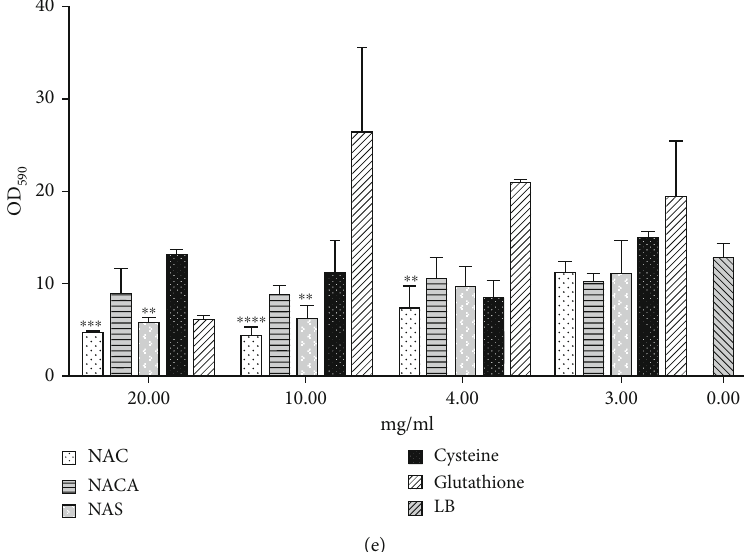
Figure 9: The e ff ects of NAC and similar molecules in dismantling bio fi lm. (a) Structures of molecules similar to NAC used in this experiment: N -acetyl-cysteine amide (NACA), N -acetyl-serine (NAS), cysteine (Cys), and glutathione (GTH). (b) Chronic wound microbiome bio fi lm formation after the treatment at time 0h with the di ff erent molecules with concentration ranging from 0 to 20mg/ml. > 4mg/ml of NAC, NAS, and GTH interfered with chronic wound microbiome cell growth. However, the same amount of NACA and cysteine did not a ff ect cell growth. (c) Quanti fi cation of the bio fi lm formation from (b) using crystal violet (CV) staining. Compared to LB media as the control, ≥ 4mg/ml NAC, NAS, and GTH were able to stop the formation of bio fi lm. ≥ 4 mg/ml NACA did not a ff ect cell growth in (b), yet signi fi cantly reduced bio fi lm. The application of 3-20mg/ml Cys to chronic wound microbiome culture did not increase or reduce bio fi lm formation. (d) 24h chronic wound microbiome bio fi lm was treated with various molecules and the e ff ects recorded at 48 h. Bio fi lm was visually dismantled when treated with ≥ 10 mg/ml NAC and 20mg/ml NAS. NACA, cysteine, and GTH did not seem to a ff ect the bio fi lm. (e) Quanti fi cation of existing bio fi lm formation from (d) using CV staining. ≥ 7.5mg/ml NAC and ≥ 10 mg/ml NAS can signi fi cantly decrease existing bio fi lm. Technical triplicates for each treatment for both cultured bio fi lm and quantitative